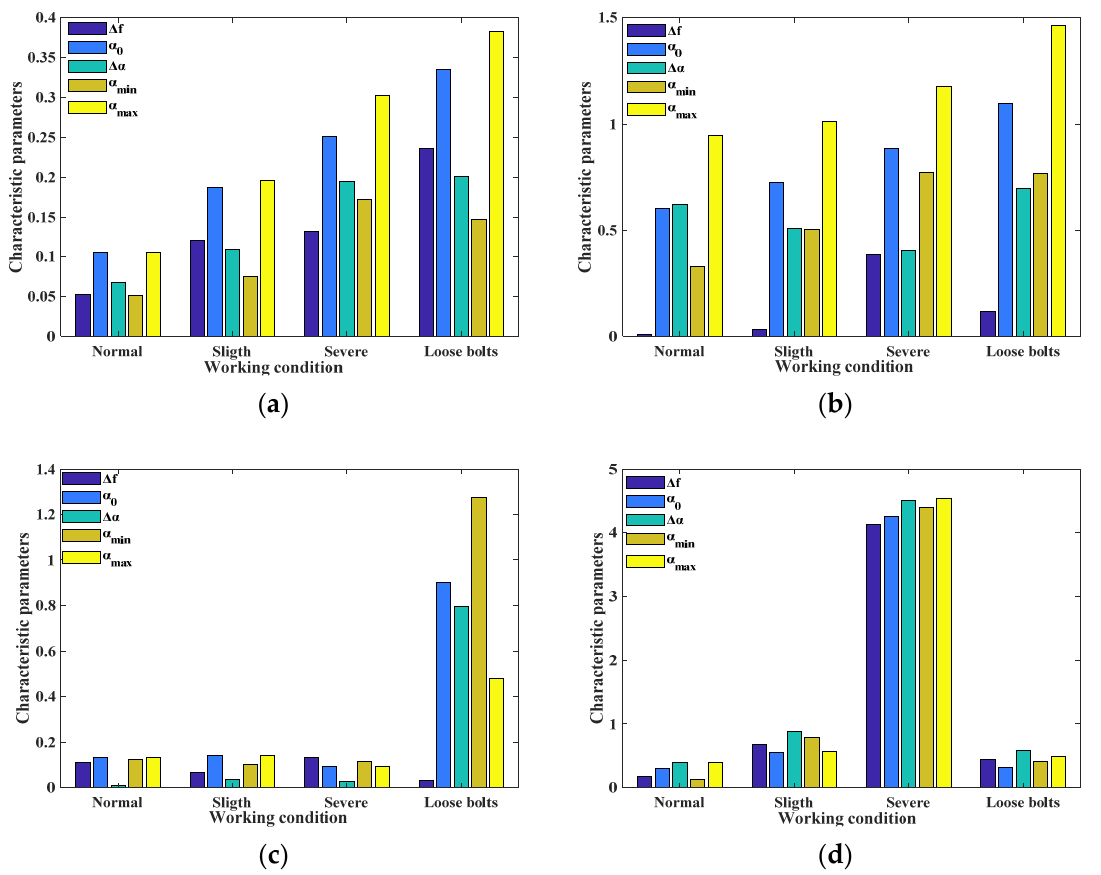
Figure 7. Characteristic parameters of 4 centrifugal pump fault state under ( a ) pump vibration signal, ( b ) torque signal, ( c ) motor vibration signal, ( d ) swing signal. ( b ) torque signal, ( c ) motor vibration signal, ( d ) swing